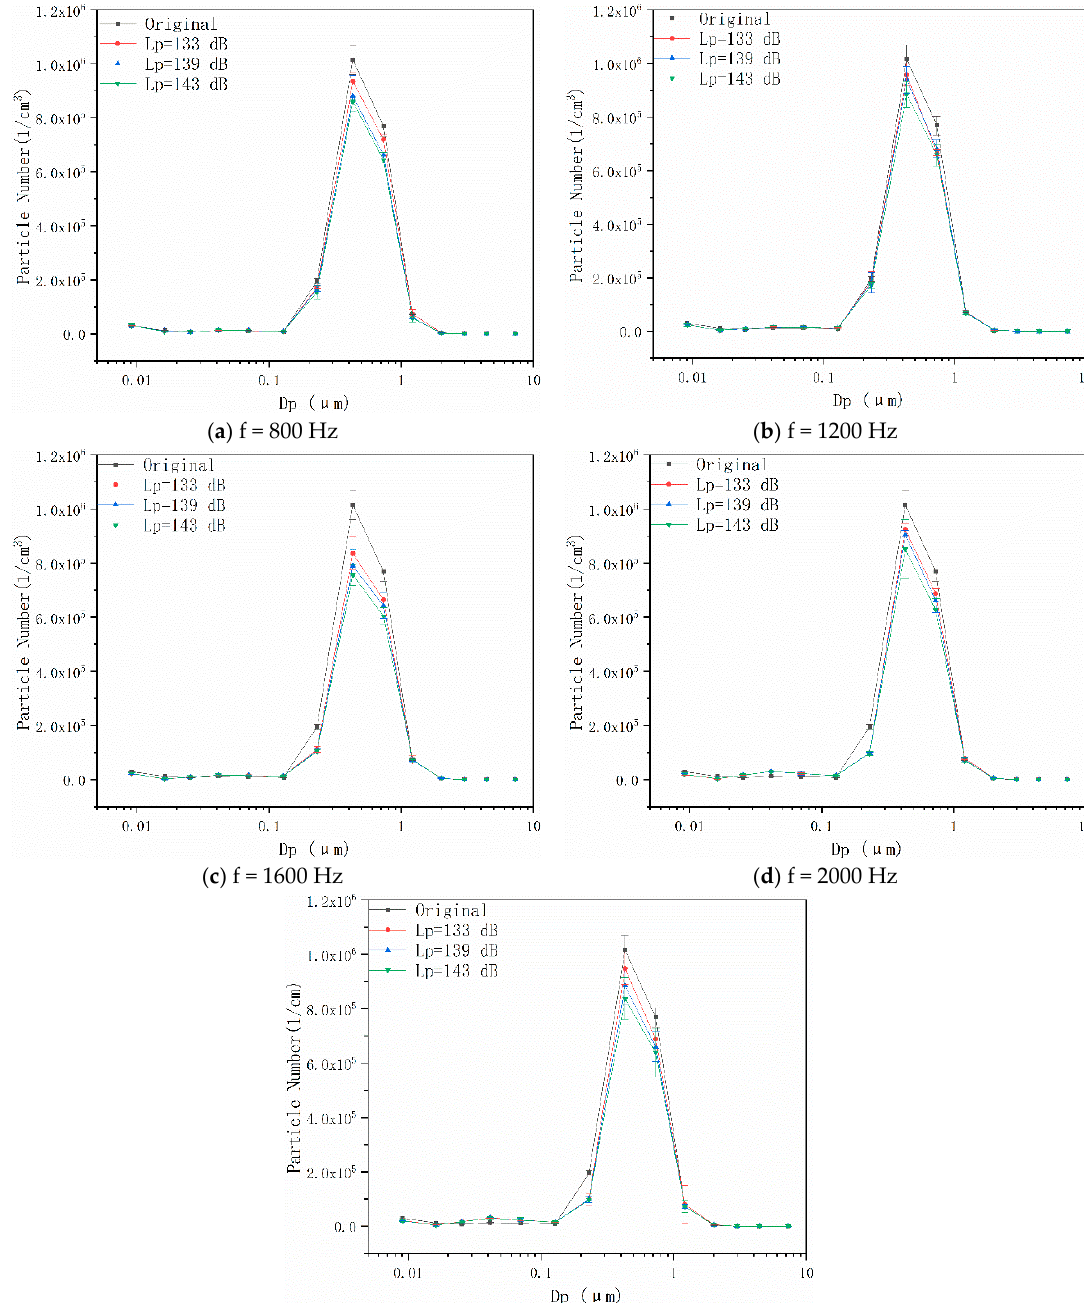
Figure 5. E ff ect of sound pressure levels (SPLs) on 0.5- µ m particles at di ff erent frequencies in Figure 5. Effect of sound pressure levels (SPLs) on 0.5- μ m particles at different frequencies in acoustic acoustic agglomeration.